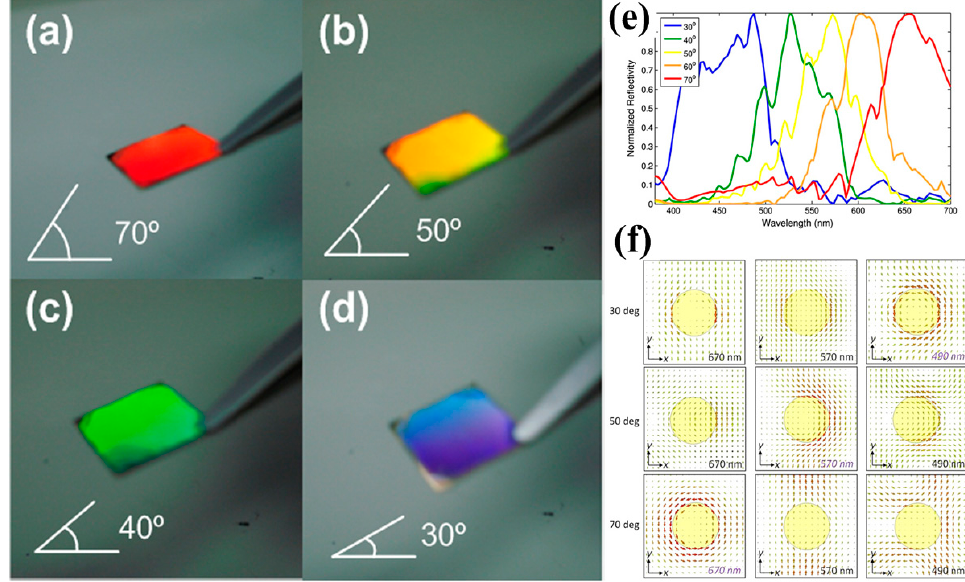
Redshift of resonance colors with increasing tilting angles can be clearly observed. ( e ) Normalized specular reflections for various angles of incidence. ( f ) Magnetic field distributions near the interface between the nanorod array and the silicon substrate at varying incident angles of 30 (top row), 50 (middle row), and 70 (bottom row) degrees and different wavelengths of 670 (left column), 570 (middle column), and 490 (right column). All figures are adapted from reference [92].